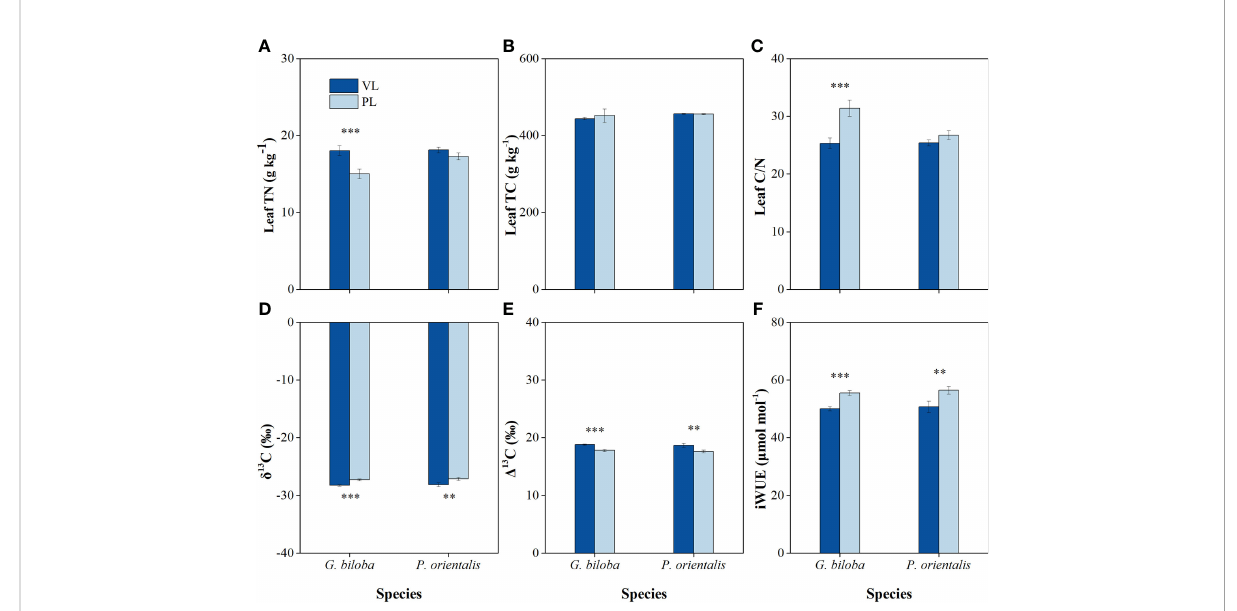
FIGURE 8 The differences in the leaf total nitrogen (TN) (A) , leaf total carbon (TC) (B) , leaf C/N ratio (C) , carbon isotope composition ( d 13 C) value (D) , carbon isotope discrimination ( D 13 C) value (E) , and intrinsic water-use ef fi ciency (iWUE) (F) between the vegetated land (VL) and the paved land (PL) at the park for G biloba and P. orientalis . Error bars indicate the standard error of the mean. ** and *** indicate statistically signi fi cant differences between VL and PL at P < 0.01 and P < 0.001, respectively.